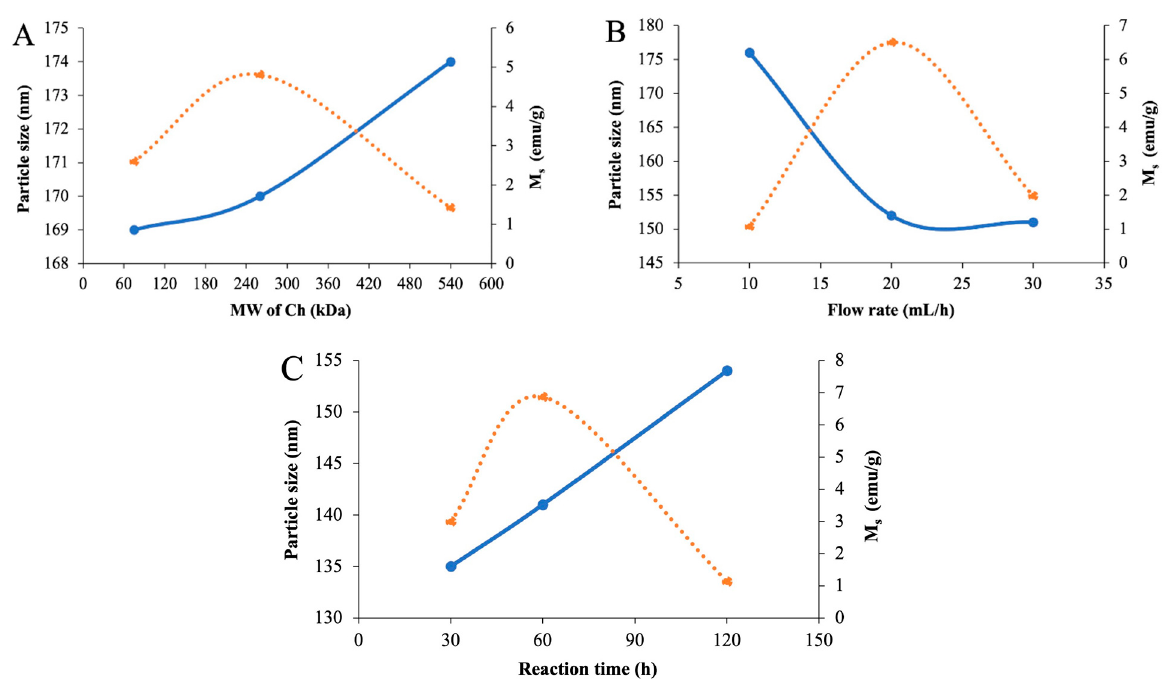
Figure 1. Effect of ( A ) MW of Ch, ( B ) flow rate of Fe precursors, and ( C ) reaction time after adding NaOH on the size (blue) and M s (red) of the Ch-IONPs.